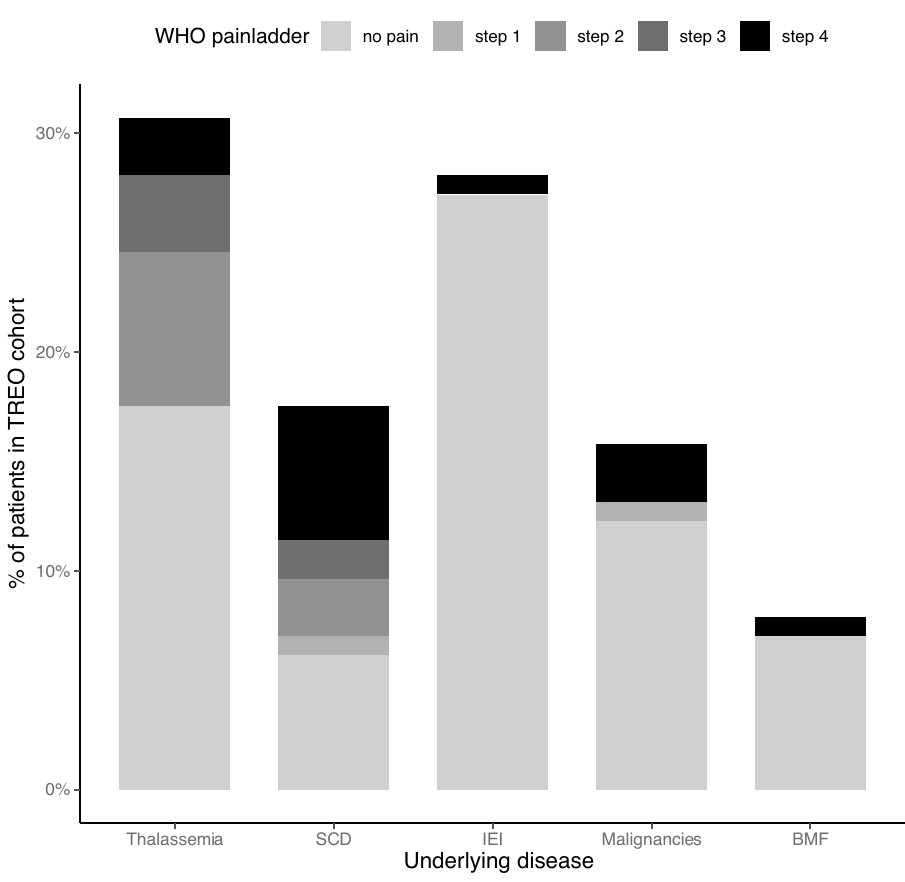
Figure 3. Pain severity (classified as steps in the WHO pain relief ladder) according to underlying disease in the TREO cohort ( SCD sickle cell disease, IEI inborn errors of immunity, BMF bone marrow